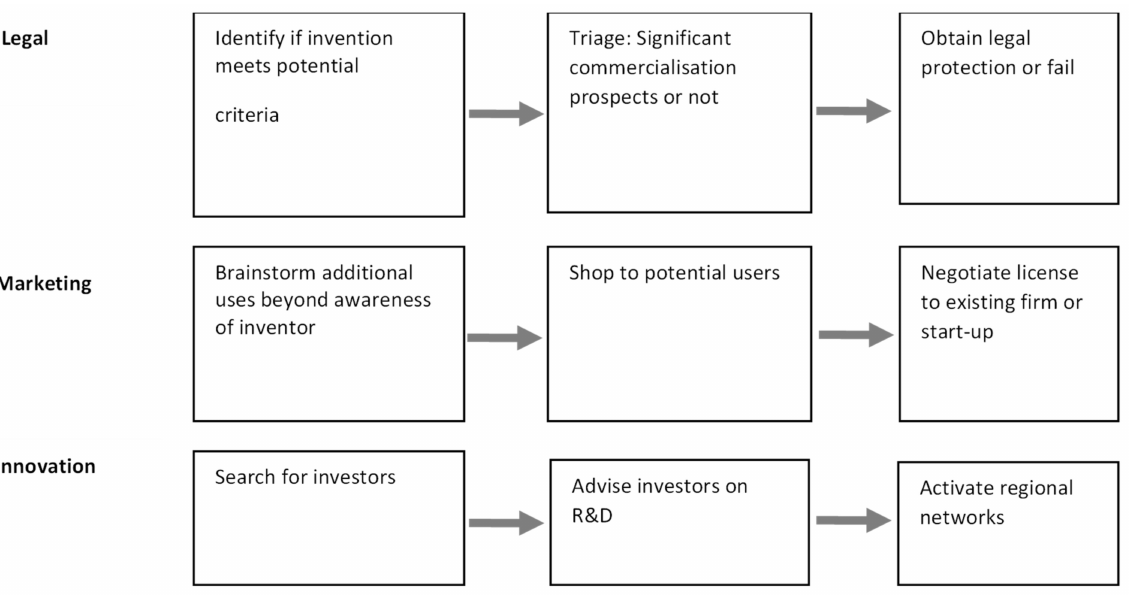
Figure 1. Non-linear TTOs stages. Source: [74,75] Etzkowitz and Goktepe-Hulten (2016).